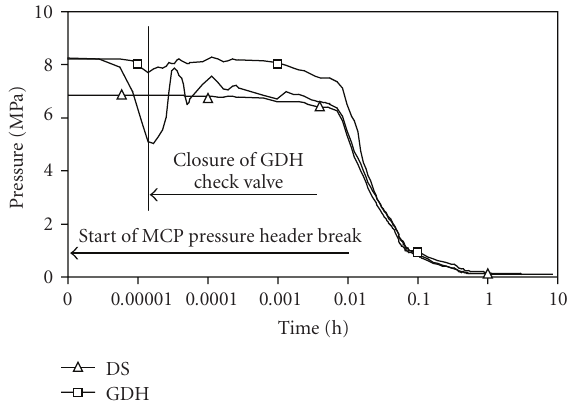
Figure 14: MCP pressure header break with failure of ECCS. Pressure behaviour in DS and GDH.